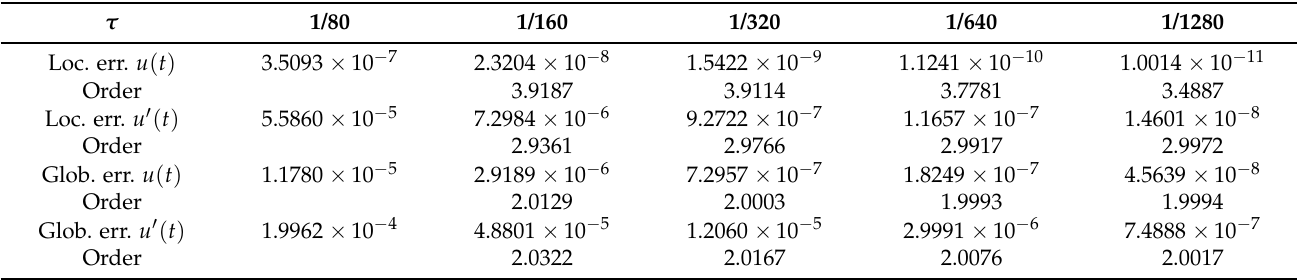
Table 7. Local and global errors and orders for problem (3) with RN2.